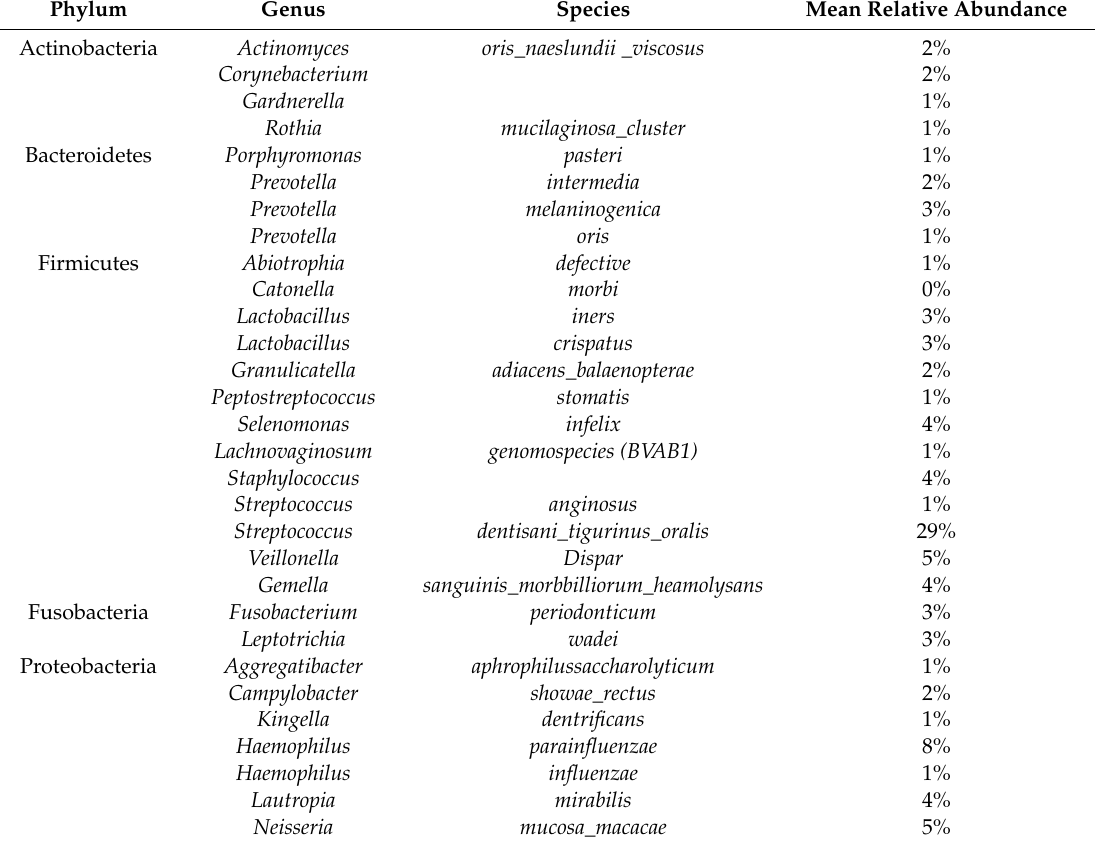
Table 2. Mean relative abundance of core oral taxa merged at lowest annotation level